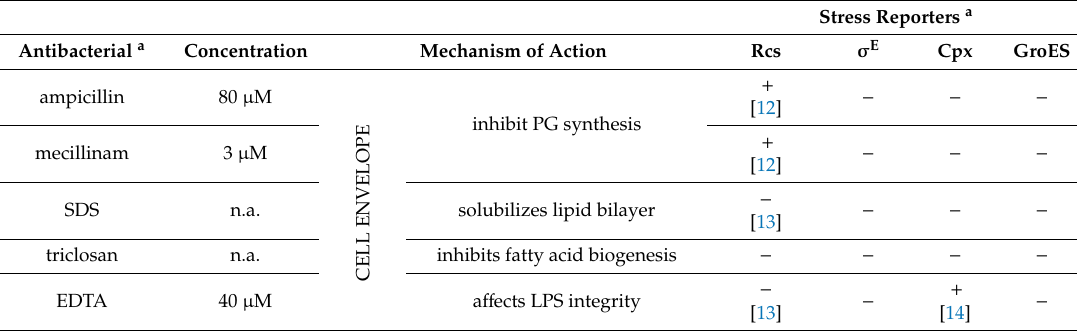
Table 1. Stress response activation by the listed antibacterial agents and their mechanism of